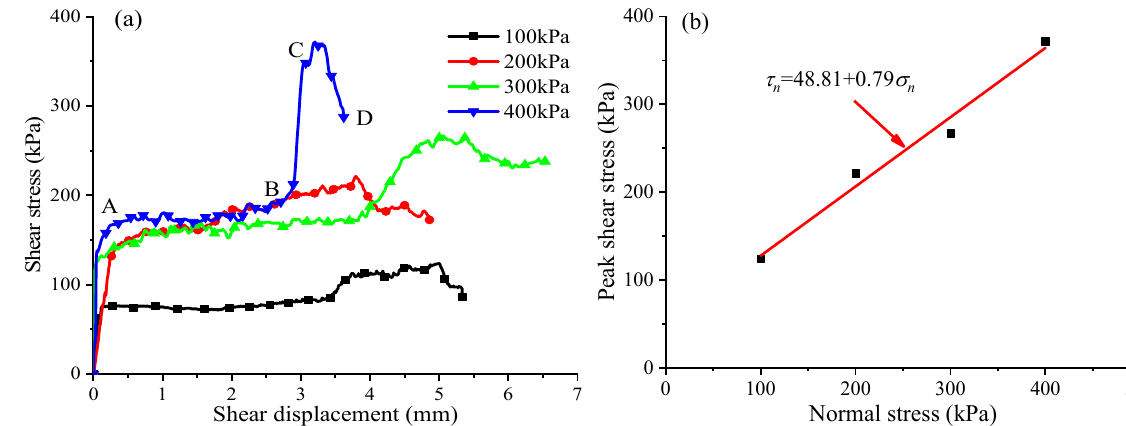
Figure 13. Results of direct shear test. ( a ) The variation in shear stress with shear displacement; ( b ) The relationship between peak shear strength and normal